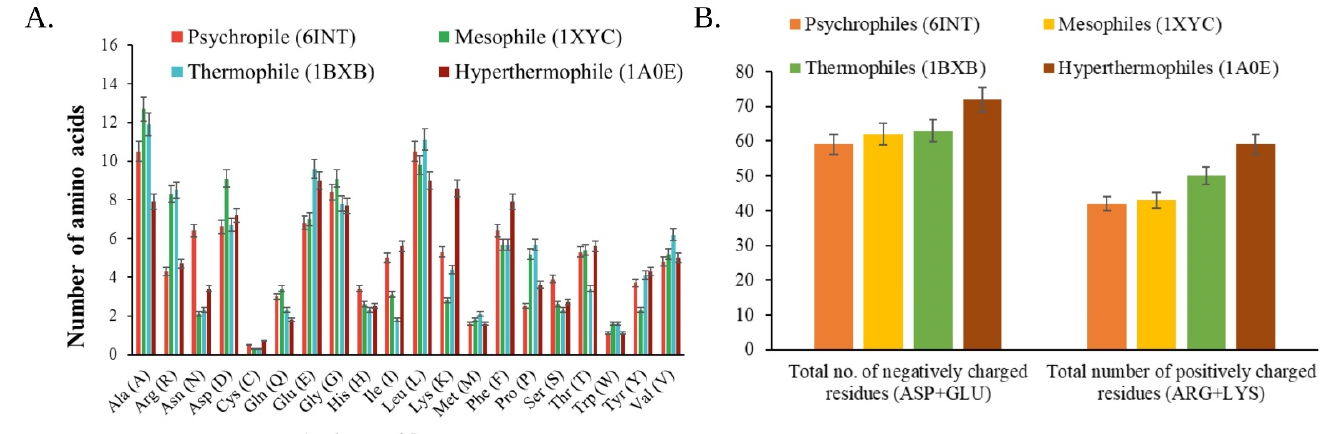
Figure 1. Diagrammatic representation of comparison of the primary, secondary, and tertiary structure between xylose isomerase from four different classes (psychrophile, mesophile, thermophile, and hy- perthermophile). ( A ) percentages of amino acids contributing to structural configuration, ( B ) number of positively charged (ARG + LYS) and negatively charged (ASP + GLU) amino acid residues, ( C ) different kinds of secondary structures, ( D ) salt bridge composition along with mean